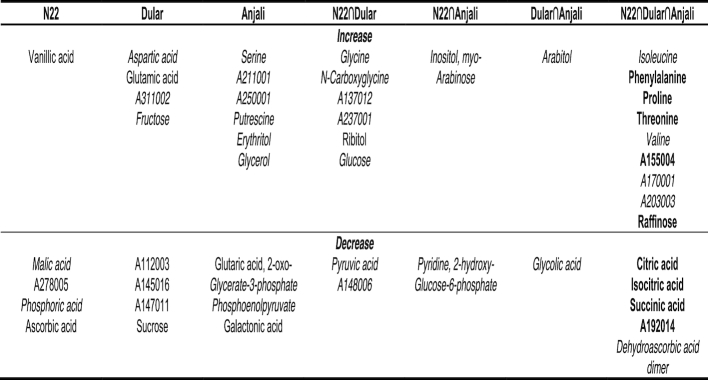
Common and cultivar-specific stress-responsive metabolites in flag leaves during early grain filling. Metabolites correspond to the numbers in the Venn diagrams in Fig. 6E and F. Responses of flag leaves to severe stress common between the flowering (Fig. 7) and early grain-filling stages are indicated by font style: boldface: common response among all cultivars between the 2 stages; italics: cultivar-specific metabolites with similar responses in the same cultivars across the 2 stages. Glyceric acid−3-phosphate is listed as glycerate-3-phosphate; phosphoenolpyruvic acid as phosphoenolpyruvate.